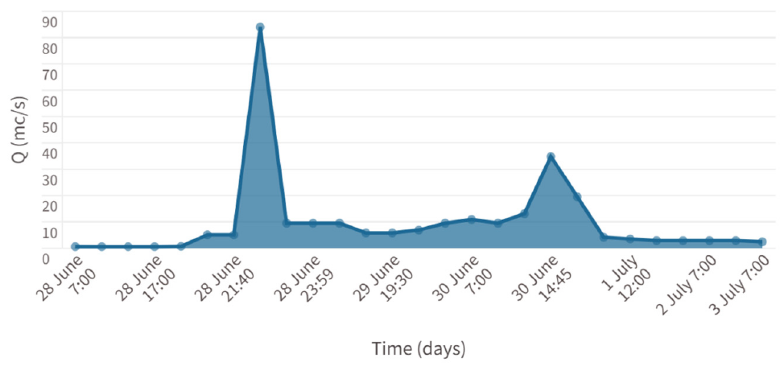
Figure 2. Hydrograph of the 2010 flood event on the Sucevi ţ a river.